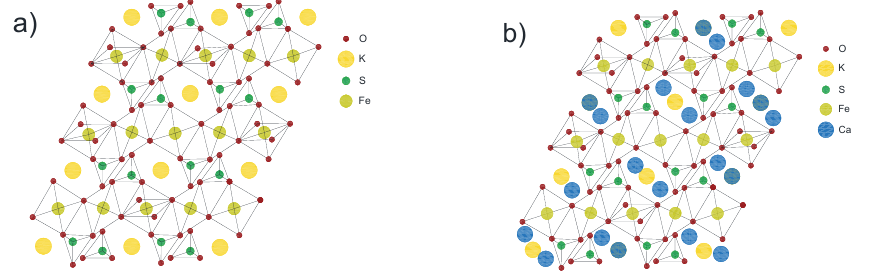
Figure 11. Representation of the crystalline structure of ( a ) the potassium jarosite, and ( b ) Ca doped potassium jarosite .